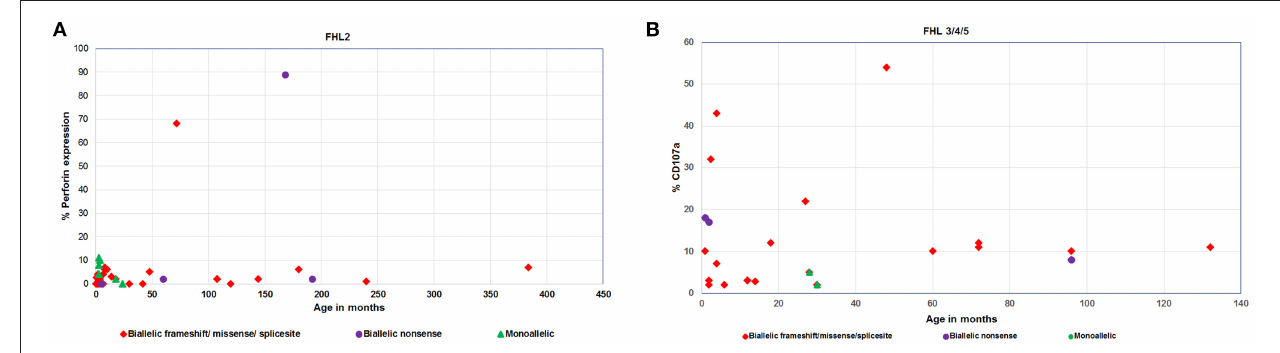
FIGURE 3 | Evaluation of age of presentation of disease (A,B) , Perforin expression (C) and CD107a expression (D) on stimulated NK cells in different groups of FHL patients with associated genetic profiles.